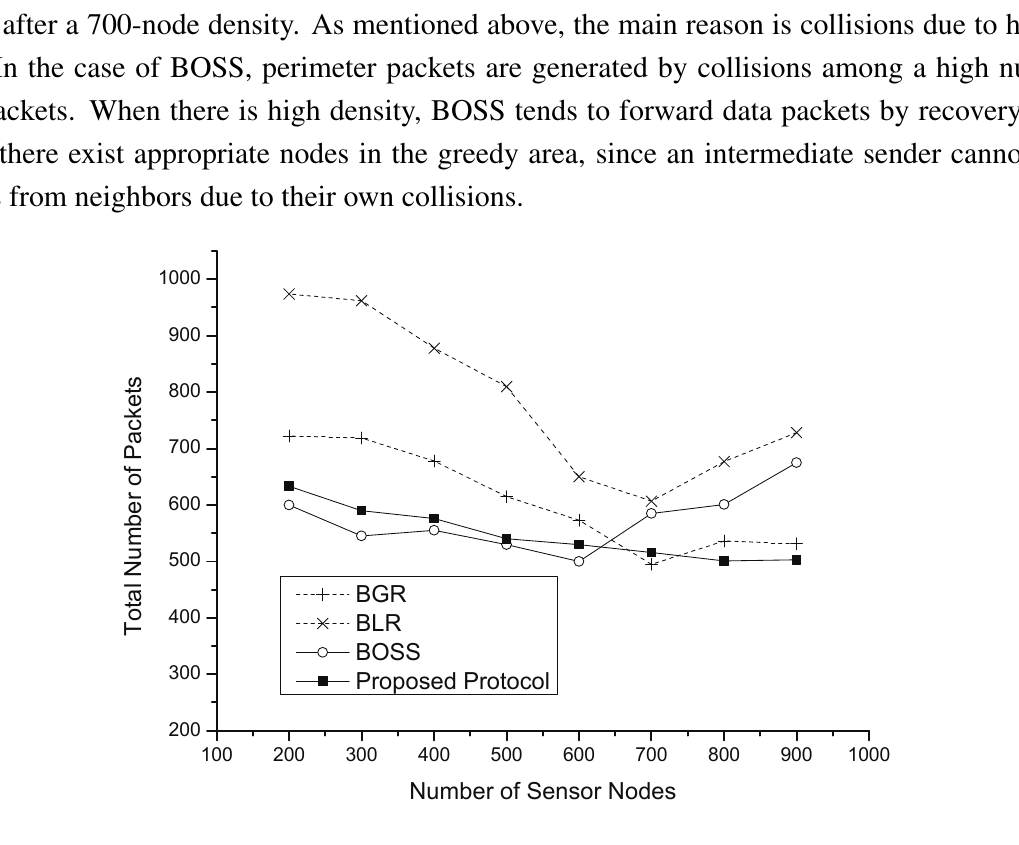
Figure 9. Total number of packets vs. the number of sensor nodes.